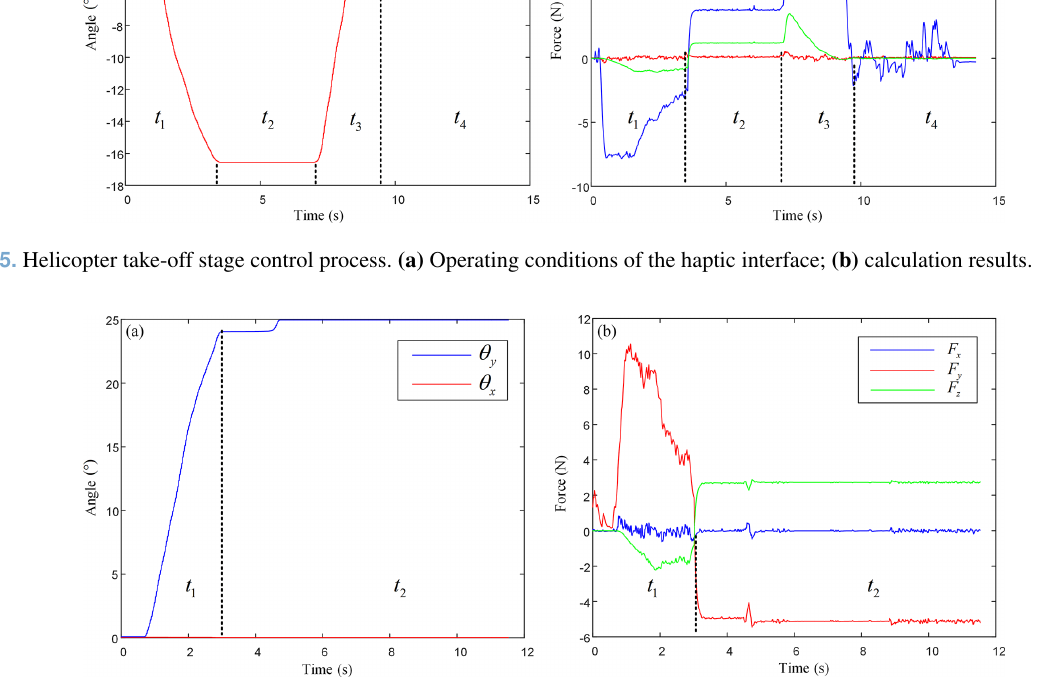
Figure 16. Helicopter hovering to the left. (a) Operating conditions of the haptic interface; (b) calculation